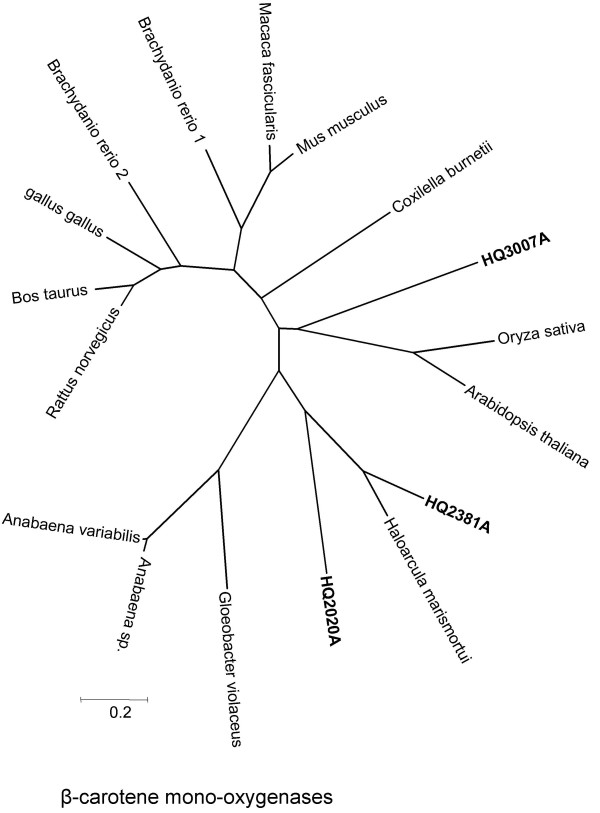
Phylogenetic tree showing the position of the three β-carotene 15,15' mono-oxygenase homologs HQ2020A, HQ2381A, HQ3007A of H. walsbyi. Trees were constructed with the neighbor-joining method using 1000 bootstrap replicates.